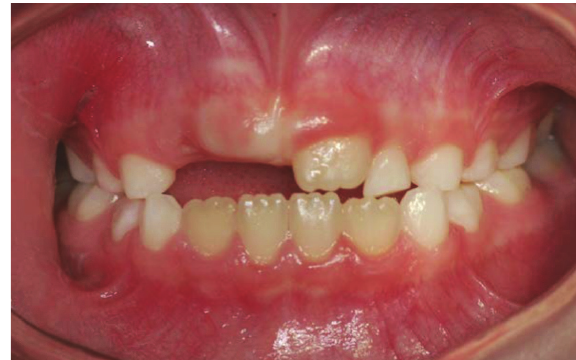
Figure 2: Frontal clinical view of the maxillary and mandibular